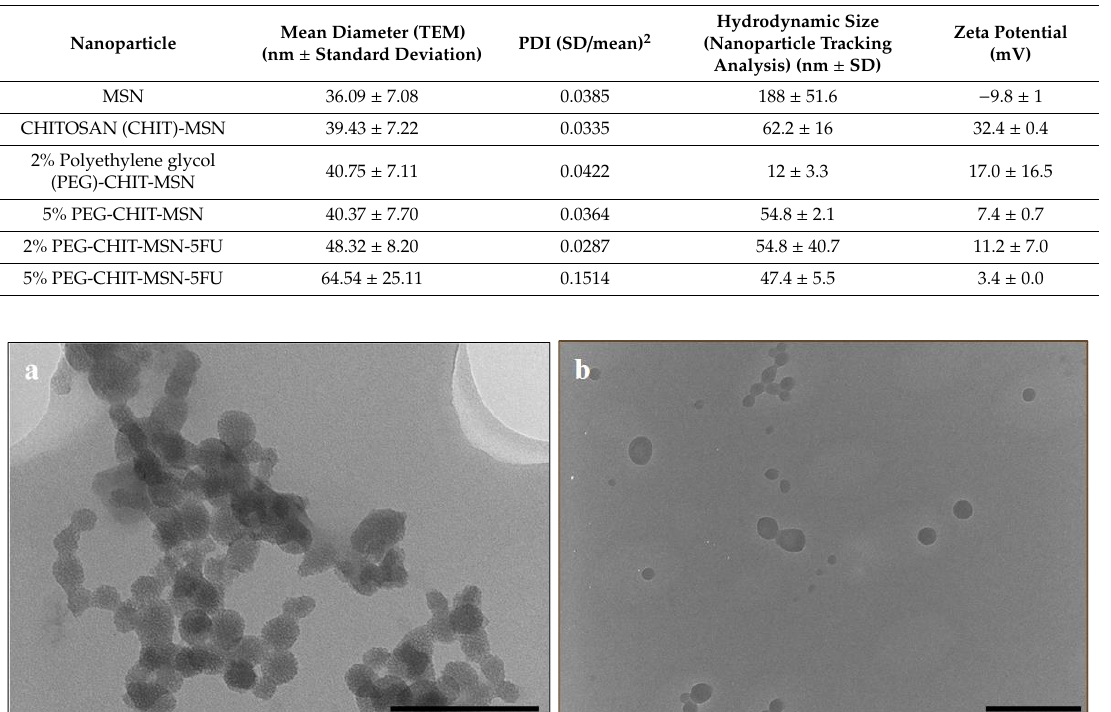
Figure 1. Selected transmission electron microscopy images: ( a ) Chitosan-mesoporous silica nanoparticles (CHIT-MSNs) (scale bar = 200 nm) and ( b ) 5-fluorouracil loaded 5% polyethylene glycol-CHIT-MSNs (scale bar = 500 nm).